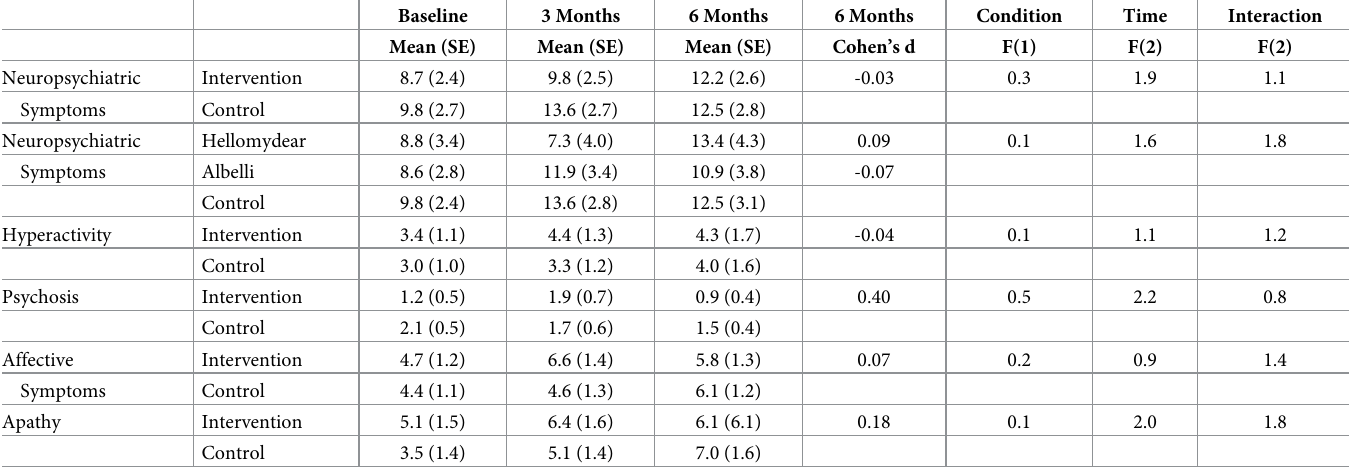
No significant differences.